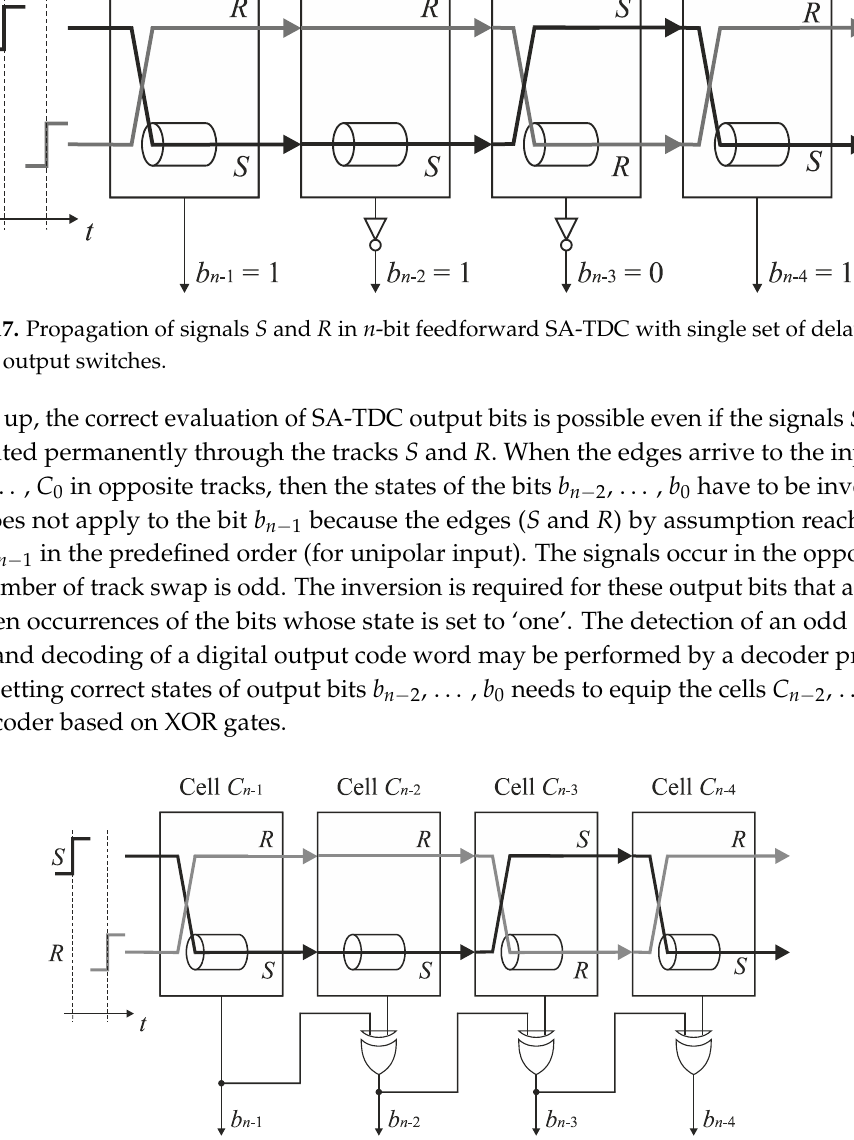
Figure 18. SA-TDC with single set of delay lines and without output pair of switches.